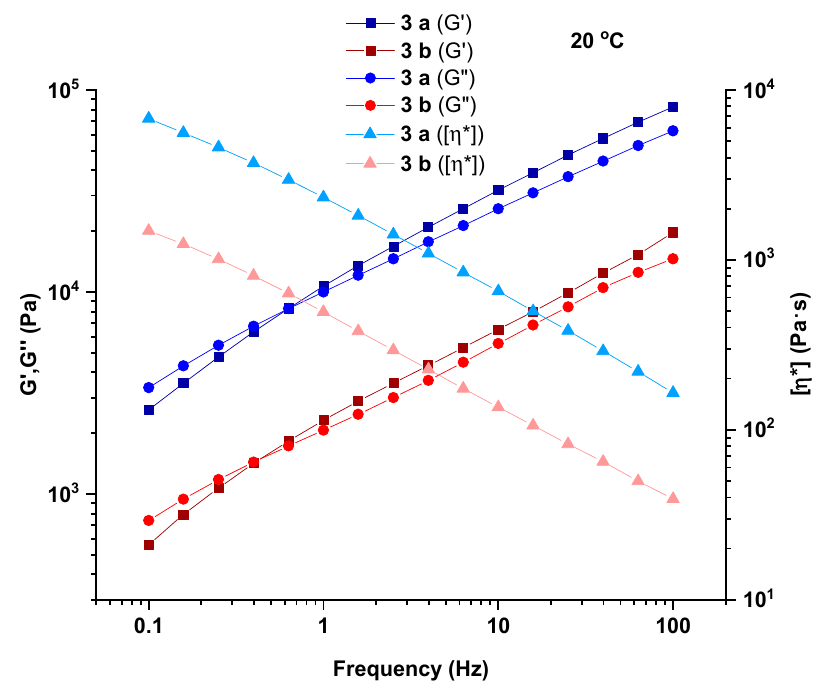
Figure 15. Frequency dependences of G ′ , G ″ and [ η *] for polymers 3 a,b at 20 °C.